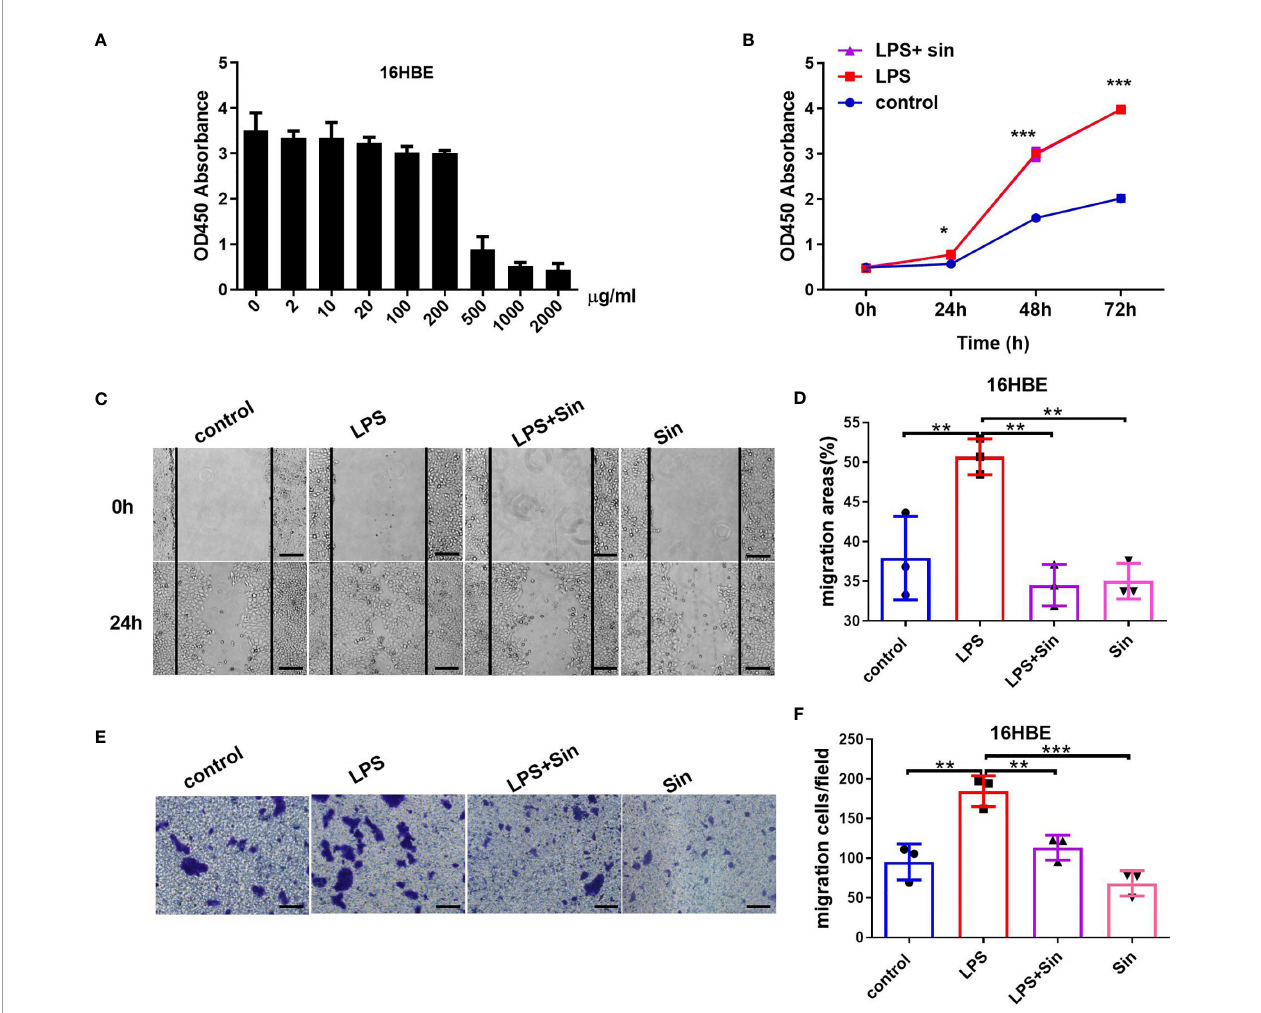
FIGURE 1 | Sin inhibited cell migration but not proliferation in LPS-exposed 16HBE cells. (A) A total of 2×10 4 16HBE cells were seeded in 96-well plates and stimulated with Sin at concentrations of 0, 2, 10, 20, 100, 200, 500, 1000, 2000 m g/mL for 24 h. Cell viability was analyzed using a CCK-8 assay. The OD450 values of the cells stimulated at different doses are shown in the Y-axis. (B) A total of 1×10 4 16HBE cells were seeded in 96-well plates and divided into three groups: 100 m g/mL LPS, 100 m g/mL LPS and 200 m g/mL Sin, control (untreated) group. Cell proliferation ability was analyzed using a CCK-8 assay. The OD450 values of the cells at 0, 24, 48, and 72 h were detected and shown by the ordinate. (C) The cell layers were horizontally scraped using a sterile 10 m L pipette tip upon reaching 90% con fl uence in six-well plates. Images of the wound areas were captured at 0 and 24 h after stimulation. (D) Migration area was measured to analyze cell migration. (E) A total of 6×10 4 HBE16 cells were seeded onto the upper wells with no more than 200 m L serum ‐ free medium. The bottom chamber was fi lled with 800 m L 10% FBS medium with 100 m g/mL LPS, 100 m g/mL LPS with 200 m g/mL Sin, 200 m g/mL Sin, or 10% FBS medium. The migrated cells were observed and captured at 100× magni fi cation after 48 h. (F) Numbers of migration cells were counted from 6 randomly chosen fi elds. Scale bar indicates 200 m m. The data are presented as mean ± SEM from three independent experiments. The one-way analysis of variance followed by Dunnett ’ s Multiple Comparison Test was used. *p < 0.05. **p < 0.01. ***p <